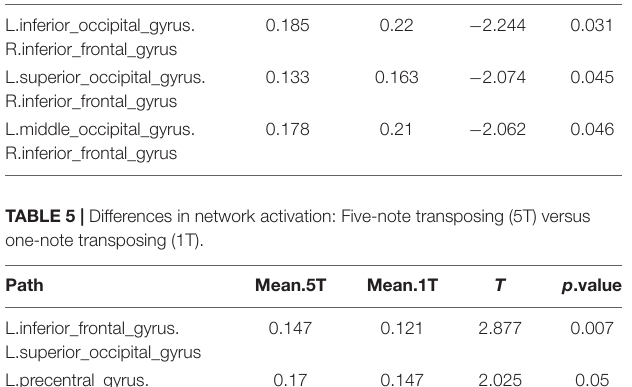
TABLE 4 | Differences in network activation: One single-digit calculation (1D) versus one note transposing (1T). Path Mean.1D